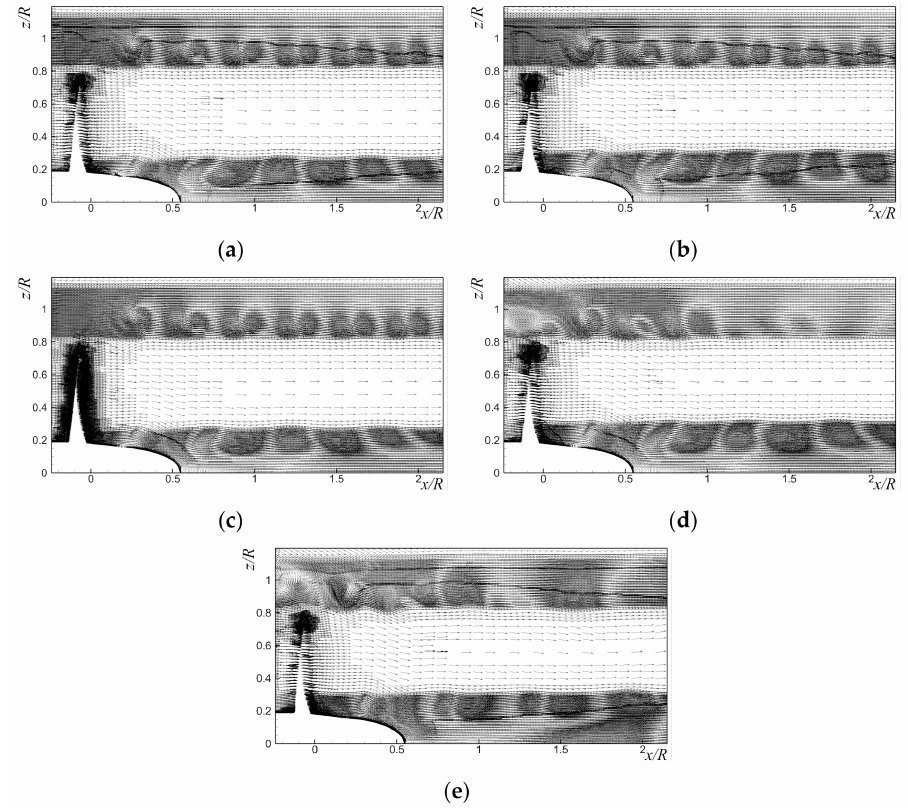
Figure 14. Instantaneous velocity vector fields in the propeller wake computed at J = 0.7 for D N / D = 0.7 : ( a ) θ = 0 ◦ , ( b ) θ = 5 ◦ , ( c ) θ = 10 ◦ , ( d ) θ = 15 ◦ , ( e ) θ = 20 ◦